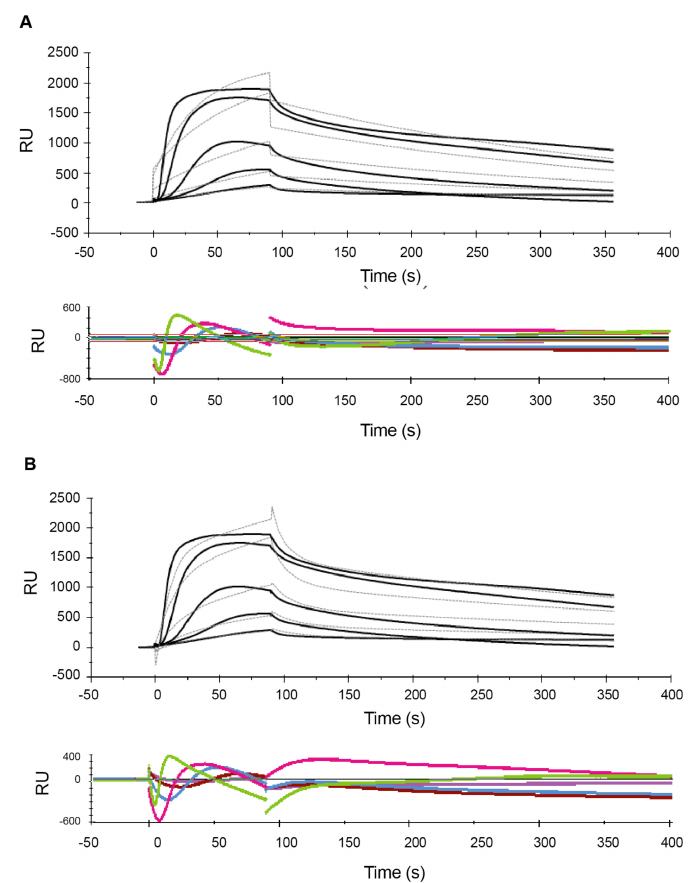
Figure 1. Sensorgrams of the melittin–POPC (1-palmitoyl-2-oleoyl-glycero-3-phosphocholine) interaction using multi-cycle kinetics for the high-range concentrations. Following immobilization of POPC liposomes (1 mM lipid) to a binding response of 8400 RU, increasing concentrations of melittin (0.5, 1, 2, 4 and 8 µ M) were serially injected at a flow rate of 30 µ L / min for 80 s with intermittent regeneration cycles with 10 mM glycine–HCl (pH 2.5). Binding kinetics analysis of the sensorgrams with a Langmuir 1:1 model ( A ) and a two-state reaction model ( B ) were conducted using BIAevaluation ® software. The estimated rate constants and a ffi nity values, based on both these models, are listed in Tables 1 and